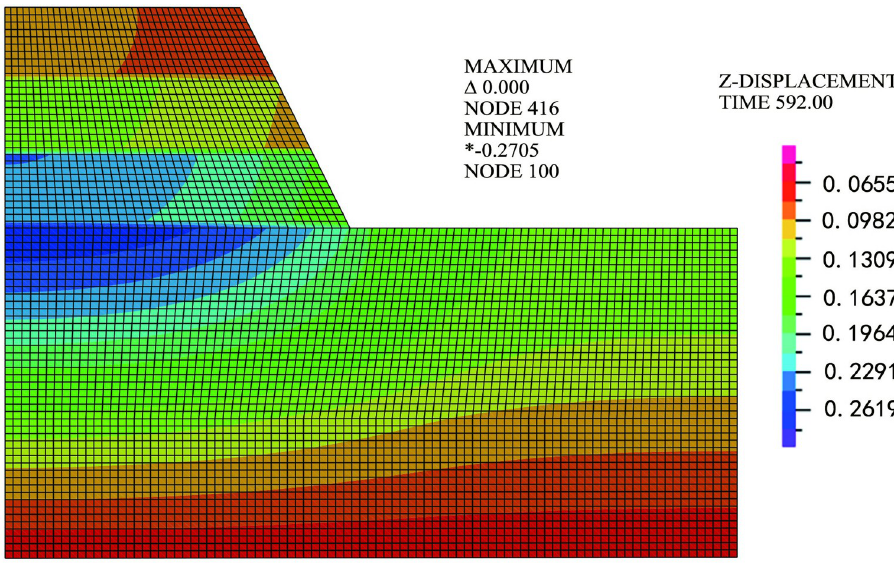
Fig 5. Vertical displacement on the 592 nd